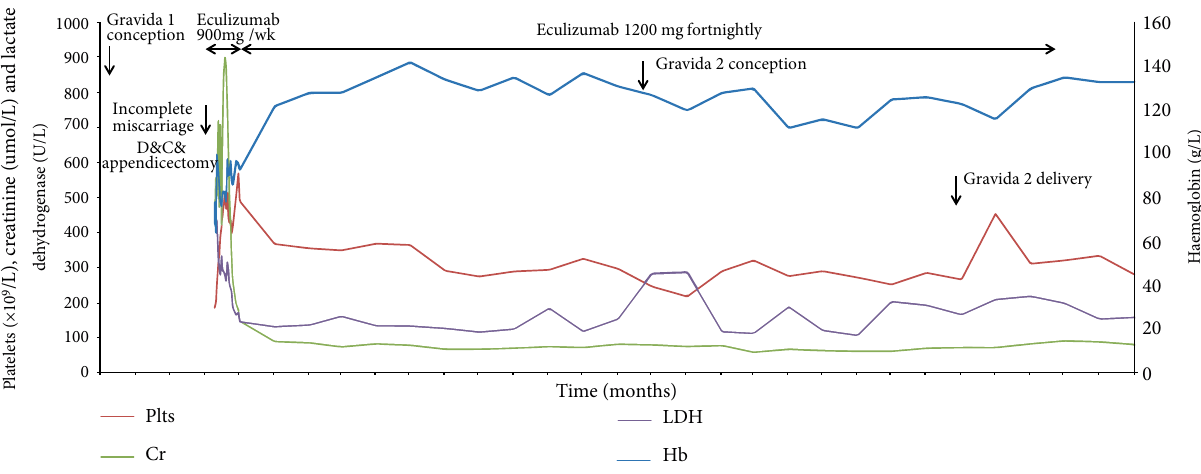
Figure 1: Trends of haemoglobin (Hb), platelets (Plts), creatinine (Cr), and lactate dehydrogenase (LDH) over